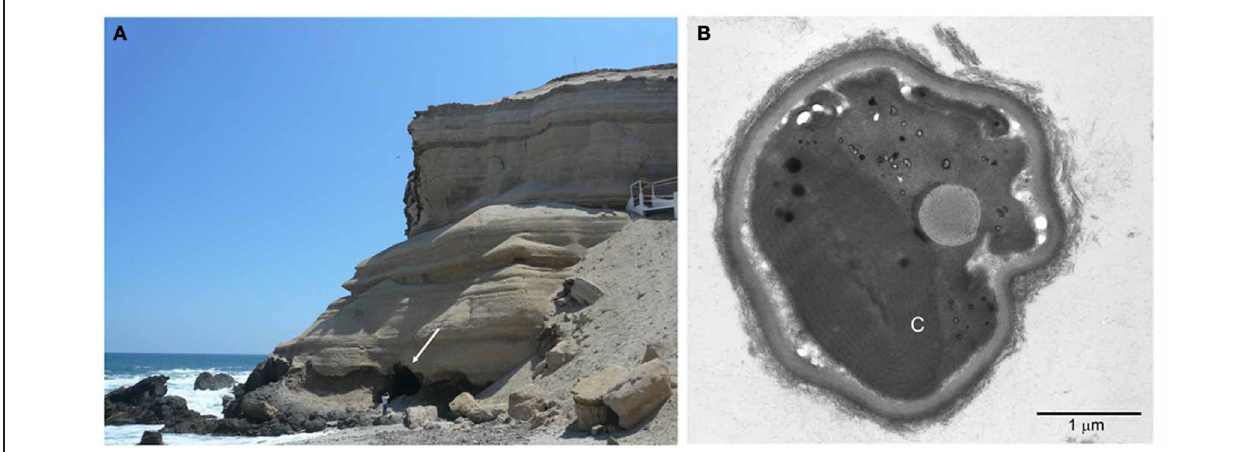
FIGURE 2 | The Cyanidium cave. (A) Image showing the location of the cave, confronting the Pacific Ocean. The white arrow points to the entrance of the cave. A person stands in the front for scale. (B) Transmission electron microscopy micrograph showing the typical ultrastructure of the cave Cyanidium . C, chloroplast.